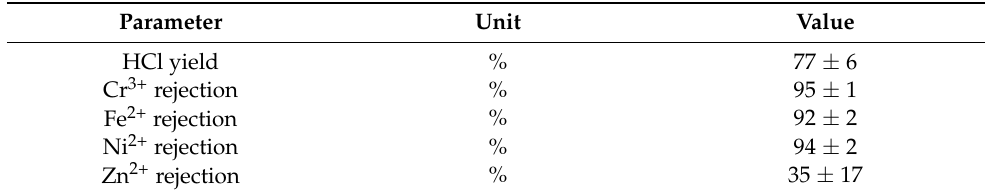
Table 2. Performance parameters of Test